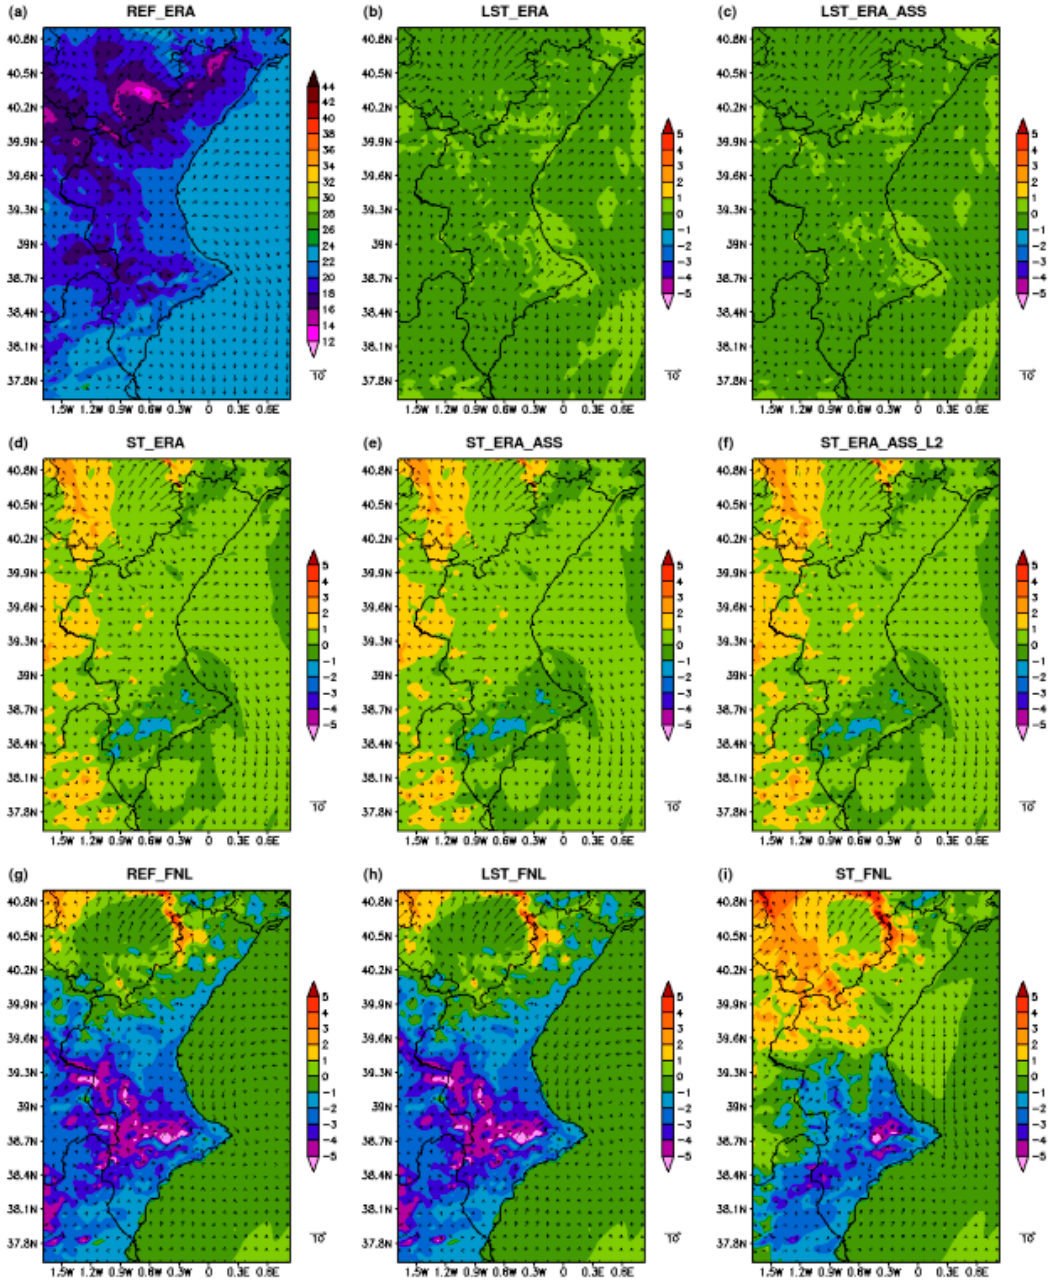
Figure 7. Same as Figure 4, but for the forecasted 2-m minimum temperature (°C) and near-surface wind field (m/s) at 06 UTC.